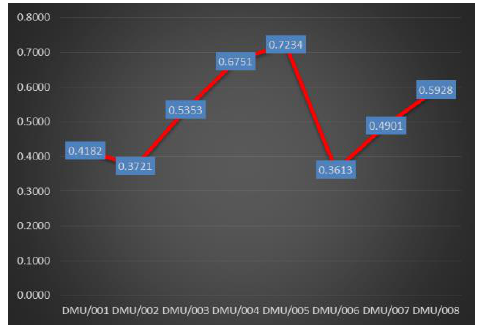
Table 5. Negative ideal solution (NIS) and positive ideal solution (PIS) values in the Technique for Order Preference by Similarity to an Ideal Solution (TOPSIS) model.